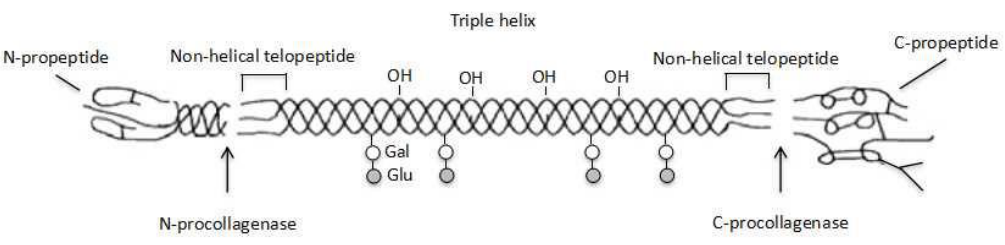
Figure 4. Schematic diagram of collagen molecule.